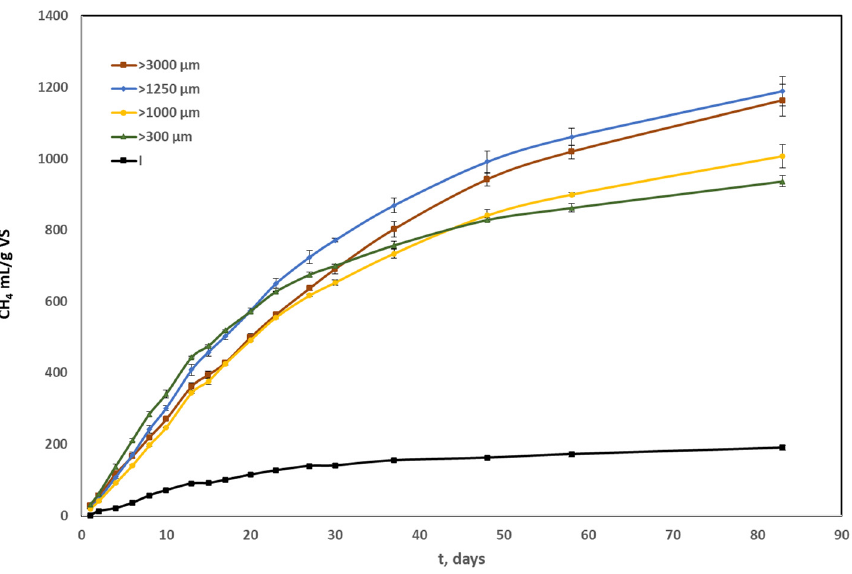
Figure 5. Biochemical methane production potential for the cumulative solid samples collected from sieves with certain sizes of openings.